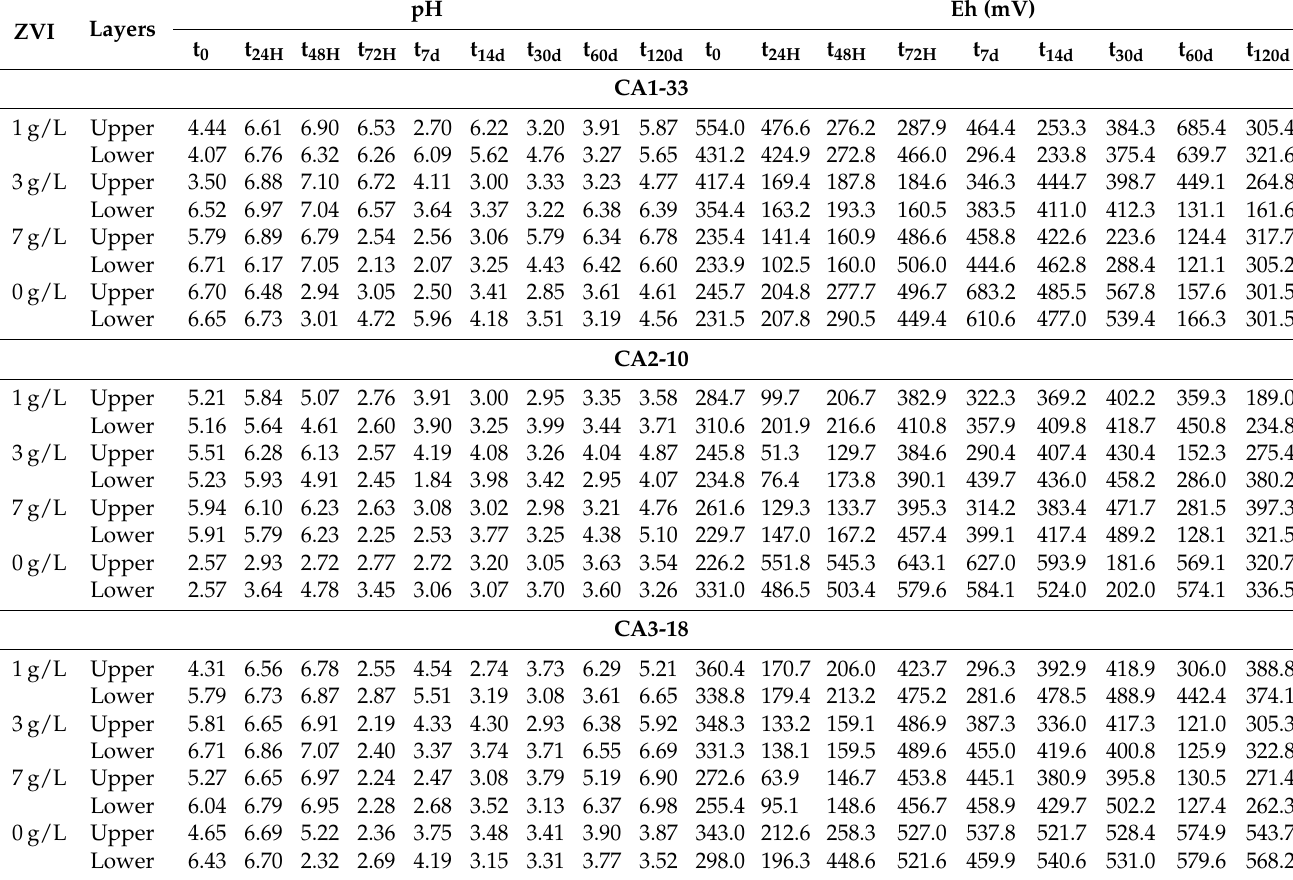
Table 3. pH and Eh values of the interstitial water extracted from the upper and lower layers of the samples, in each selected period, for the different concentrations of nZVI